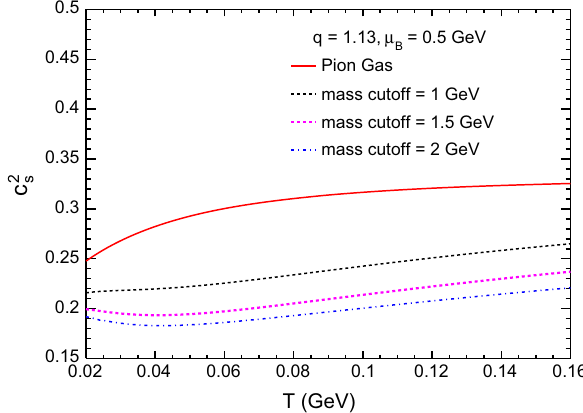
Fig. 7 Isothermal compressibility as a function of temperature for dif- ferent values of q , with μ B = 0.5 GeV